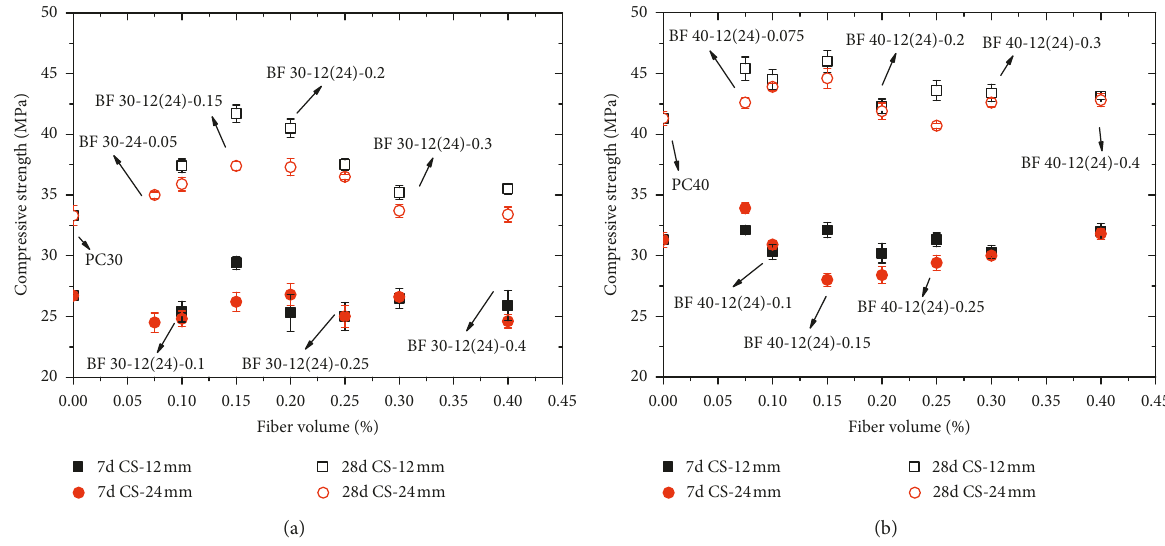
Figure 6: Effect of fiber volume fraction on BFRC compressive strength for specimens PC30 (40) and BF 30(40)-12(24)-(0.075 ∼ 0.4): (a) design CS of 30MPa and (b) design CS of